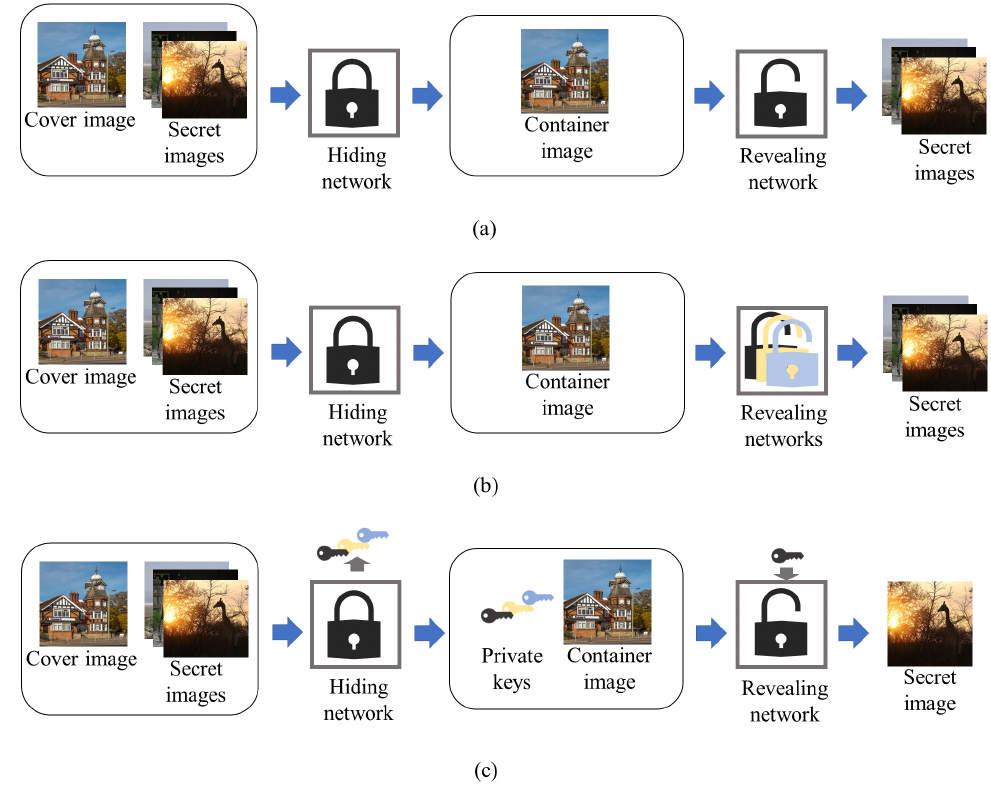
Figure 1. Comparison of image steganography models. ( a ) The conventional model does not provide individual access to each secret image. ( b ) The model has multiple revealing networks to extract hidden images, separately. ( c ) Our model supports individual access to secret images with private